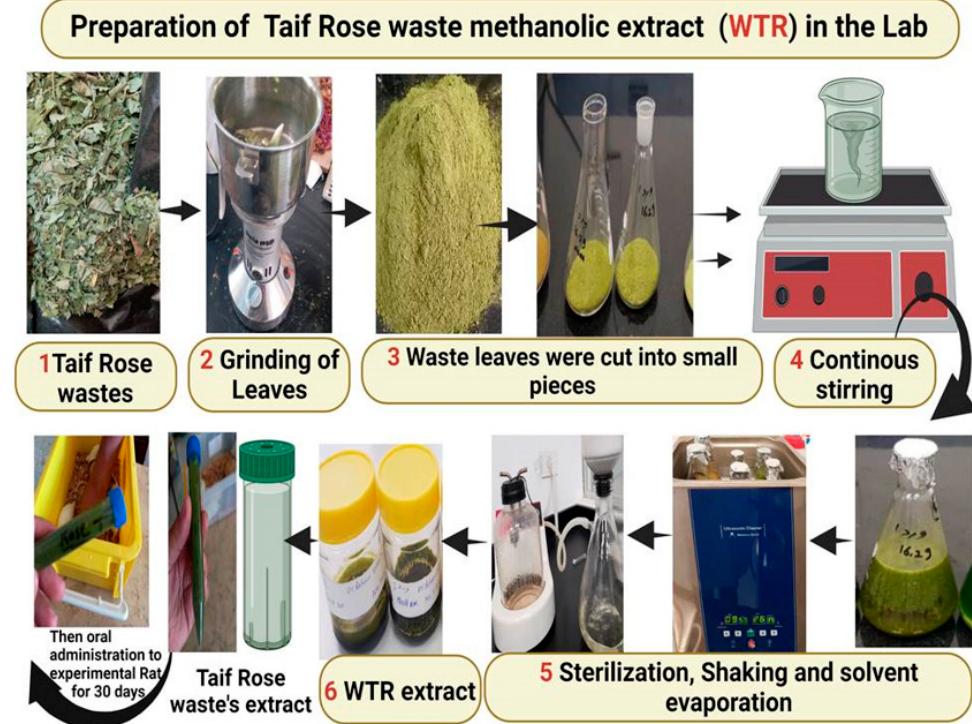
Figure 1. Graphical design for the preparation of